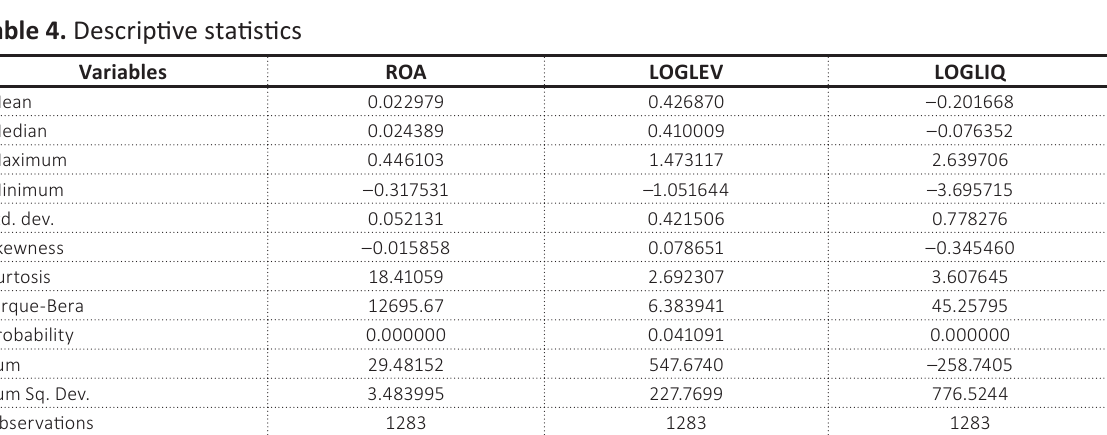
Table 4. Descriptive